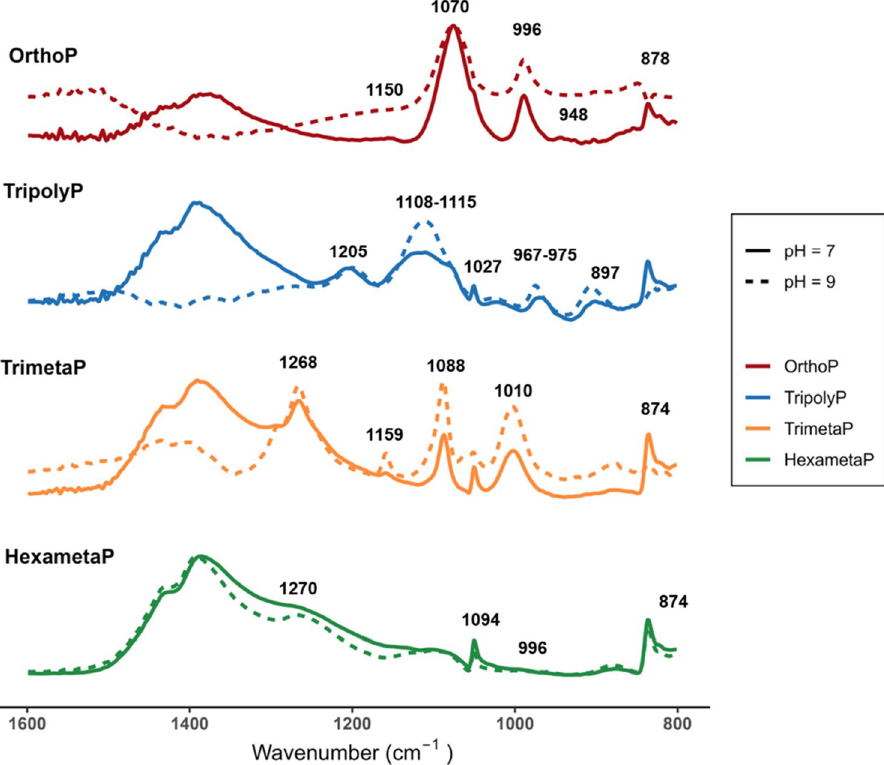
Figure 6. ATR-FTIR spectra of adsorbed phosphates as a function of pH (7.0 or 9.0) and phosphate type (OrthoP, TripolyP, TrimetaP, HexametaP) at DIC 5 mg C L −1 from the batch experiment. All ATR-FTIR spectra were recorded in a DIC 5 mg C L −1 electrolyte solution